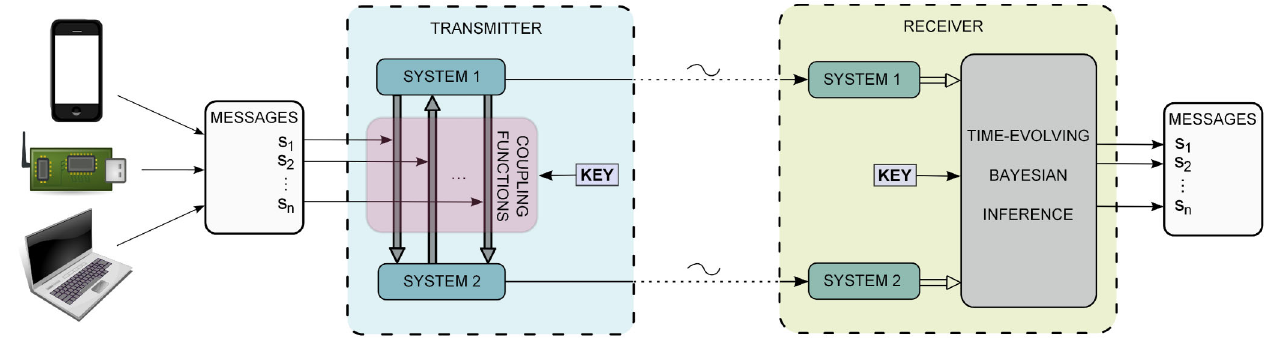
FIG. 1 Schematic of the communications scheme. Messages s 1 ; … ; s n are encrypted through their modulation of the coupling functions connecting the two oscillators of the transmitter. Only two signals are transmitted through the public domain. For the particular realization of the cipher discussed in the text, Eqs. (5) and (6), they are x 1 and y 2 . The receiver consists of the same kind of oscillators and the same coupling functions (effectively forming the privately shared key) as the transmitter and uses time-evolving Bayesian inference to reconstruct s 1 ; :::::; s n